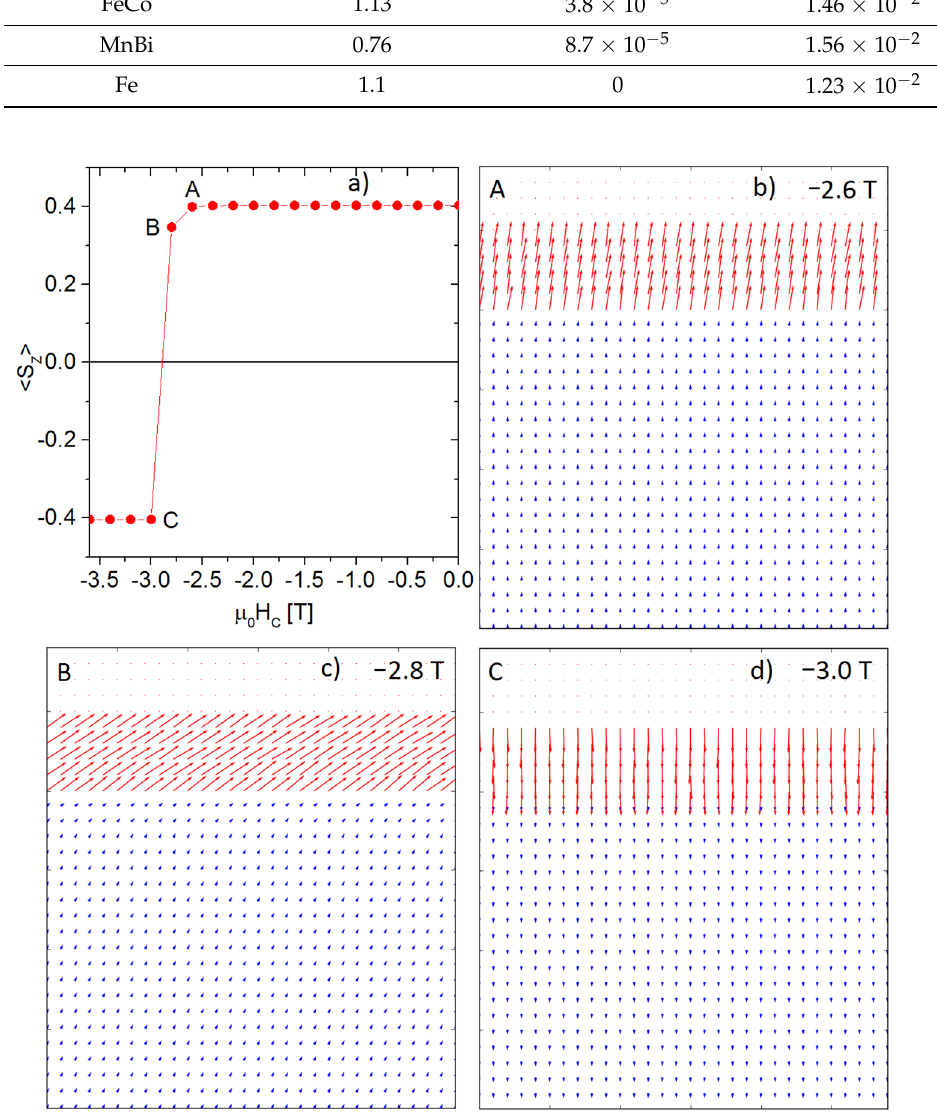
Figure 7. Reverse magnetization curve and spin configurations for the Tb 2 Fe 14 B-Fe (20% Fe) system near the coercivity point. ( a ) reverse magnetization curve ( b ) spin configuration for the point A ( c ) spin configuration for the point B ( d ) spin configuration for the point C